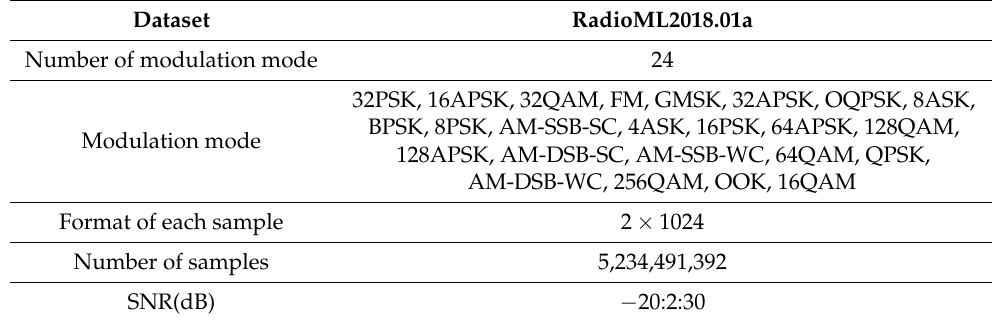
Table 9. Description of display parameters for RadioML2018.01a dataset. Dataset RadioML2018.01a Number of modulation